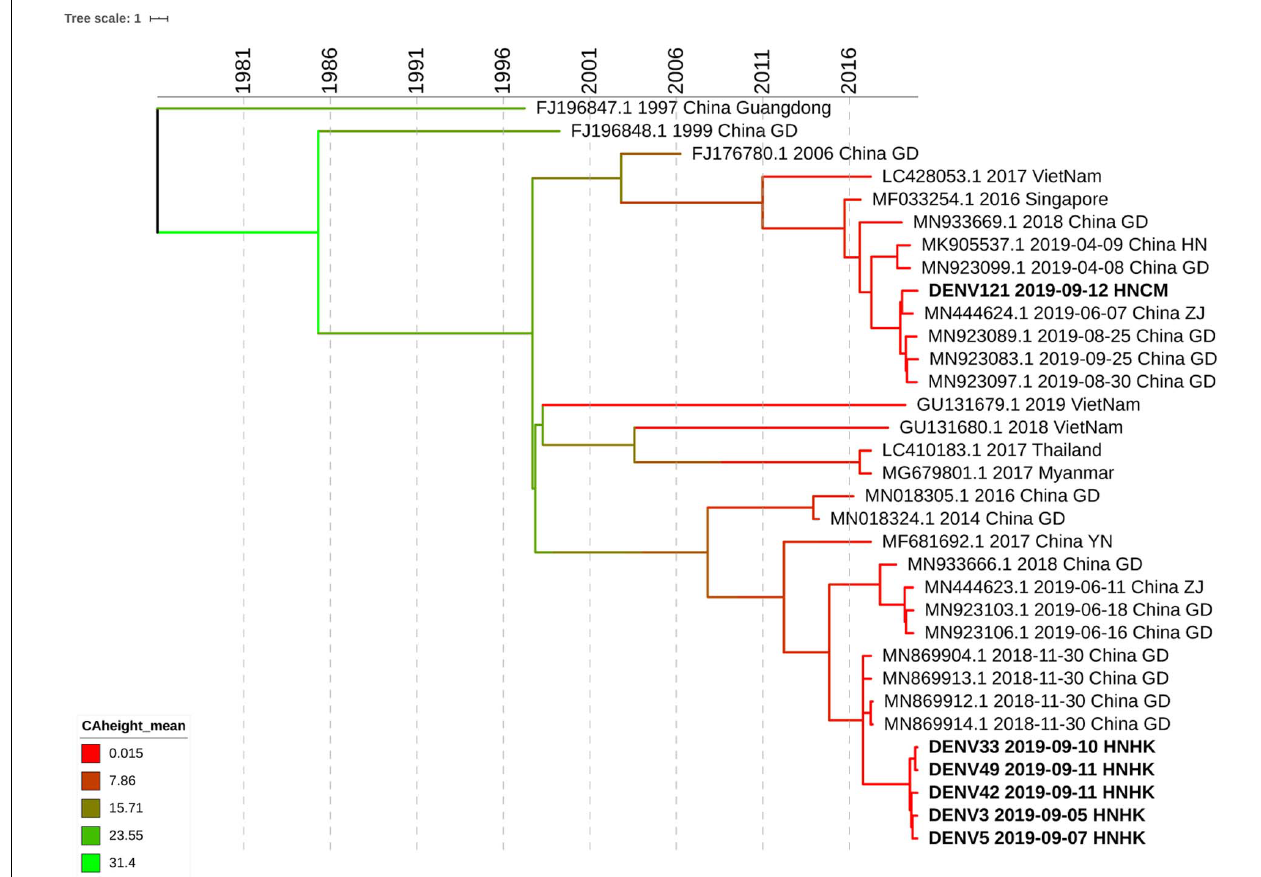
FIGURE 3 | Phylogenetic tree of DF-1 by whole-genome sequences. Bayesian phylogenies were performed in BEASTv.2.6.0. Used Bayesian Skyline plus stick model setting to run Beast and identified the maximum clade credibility (MCC) tree. Analyses were run in duplicate for 100 million MCMC steps, sampling parameters, and trees were logged every 5,000